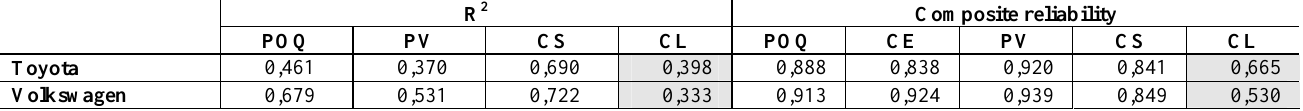
Table 3: Variance explained and composite reliability of the individual motor vehicle brands R 2 Composite